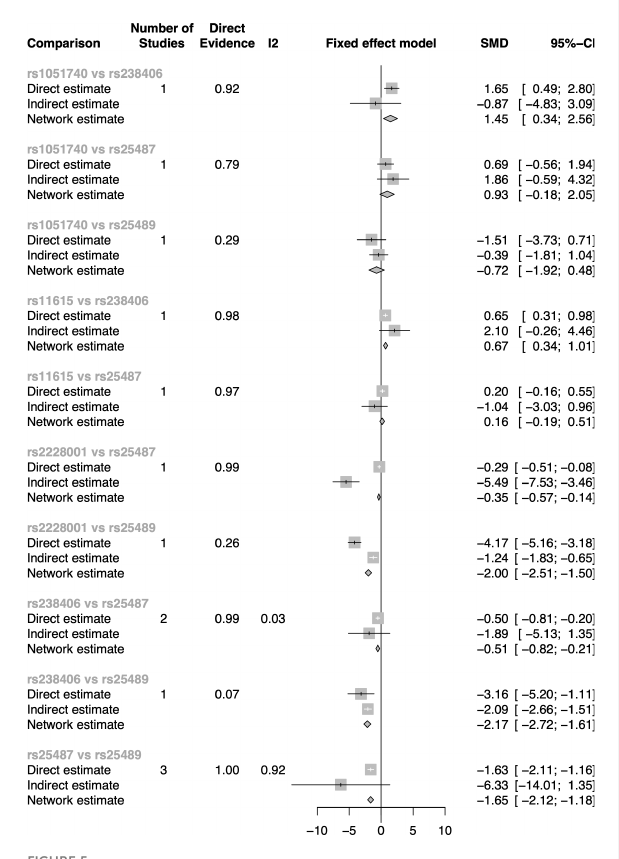
FIGURE 5 The direct and indirect evidence forest plot of subgroup two in the dominant